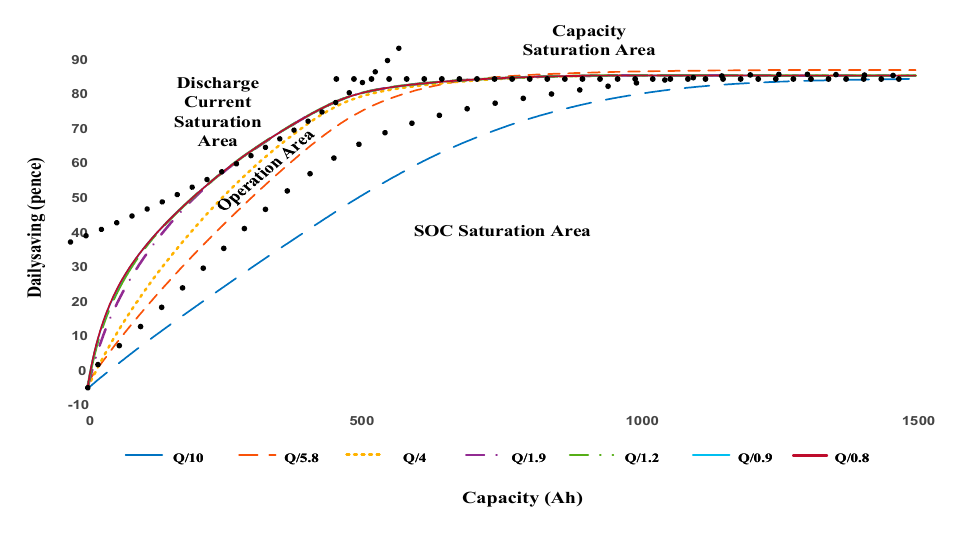
Figure 8. The limitation of HESS operation system.